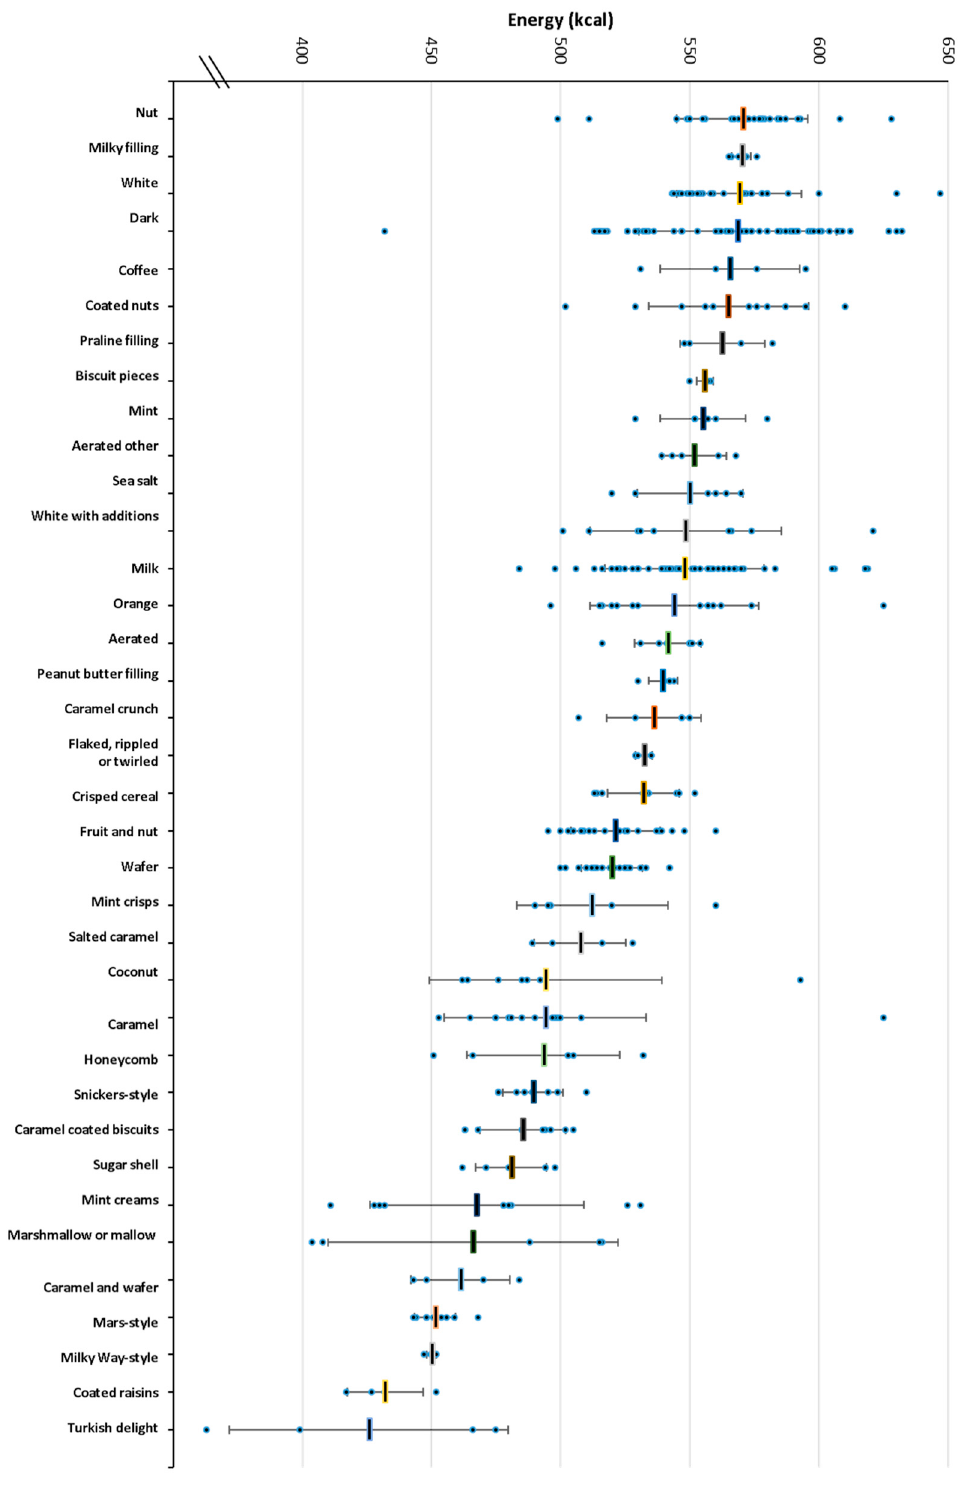
Figure 2. Energy contents of different categories of chocolate confectionery in 2017 (kcal/100 g). Values are individual products within each category (circle) with their means (rectangle) and standard errors represented by vertical bars.